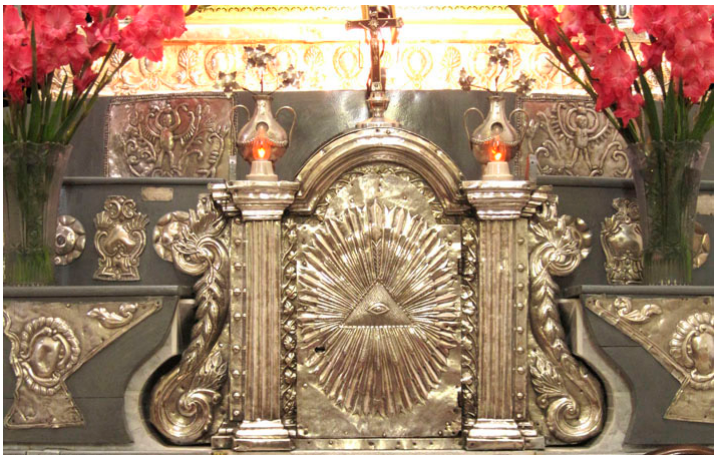
Figure 6. Tabernacle and candle banks, altar in the chapel of the Virgin of Guadalupe, Sucre, Bolivia (photo: Andrea Nicklisch).